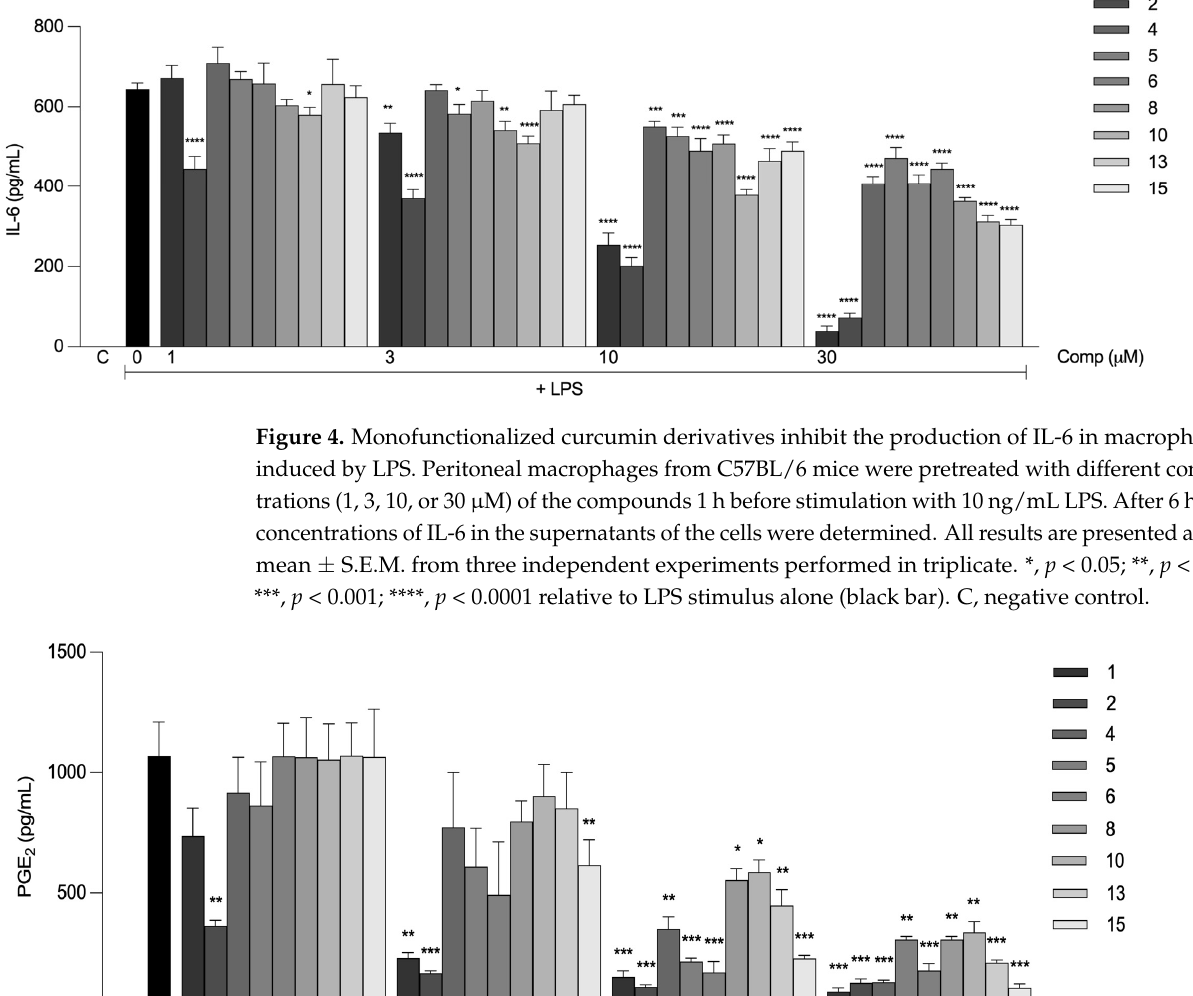
Table 1. Chemical structures and anti-inflammatory activity of the novel curcumin derivatives. Compound